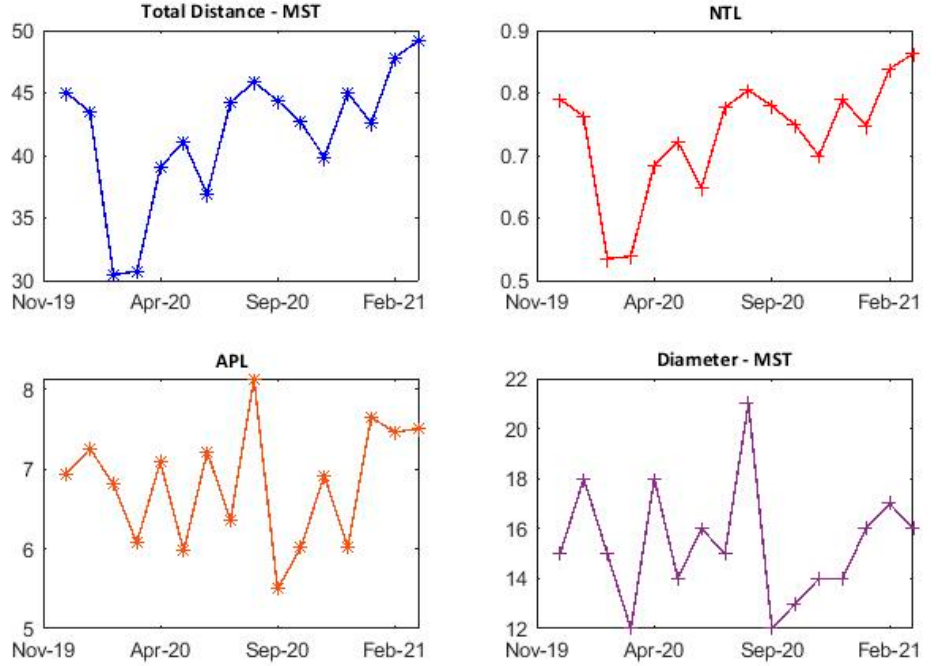
Figure 7. Dynamic evolution of total distance, normalized tree length (NTL), average path length (APL), and diameter of MST.